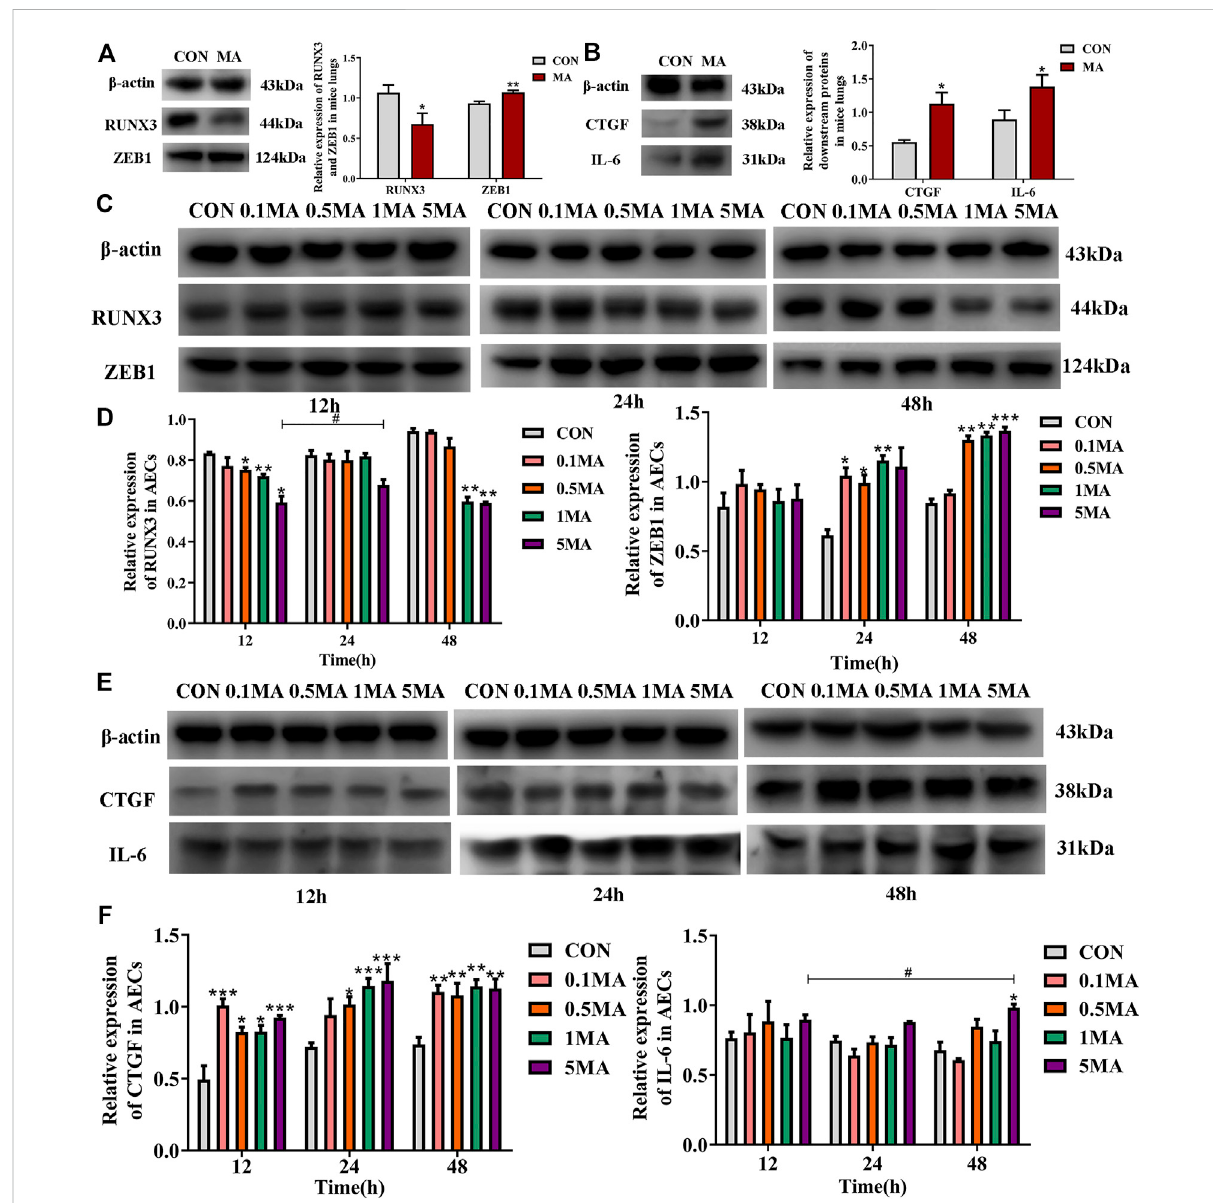
FIGURE 4 Effects of MA exposure on RUNX3, ZEB1 and its downstream signals. (A) RUNX3 and ZEB1 expression in mice lungs. (B) CTGF and IL-6 expression inmice lungs. (C) Effects ofMAexposure onRUNX3 andZEB1 expression inAECs. (D) Relativeexpression ofRUNX3and ZEB1 inAECs. (E) Effects of MA exposure on CTGF and IL-6 expression in AECs. (F) Relative expression of CTGF and IL-6 in AECs. N = 6 (A , B) , n = 3 (C – F) . Data are expressed as mean ± standard deviation, * p < 0.05 vs. CON, ** p < 0.01 vs. CON, *** p < 0.001 vs. CON; # p < 0.05 vs. 5MA/12 h. AECs: Alveolar epithelial cells, CON: The control group, MA: The group treated with methamphetamine in mice, 0.1 MA: 0.1 mM methamphetamine, 0.5 MA: 0.5 mM methamphetamine, 1 MA: 1 mM methamphetamine, 5 MA: 5 mM